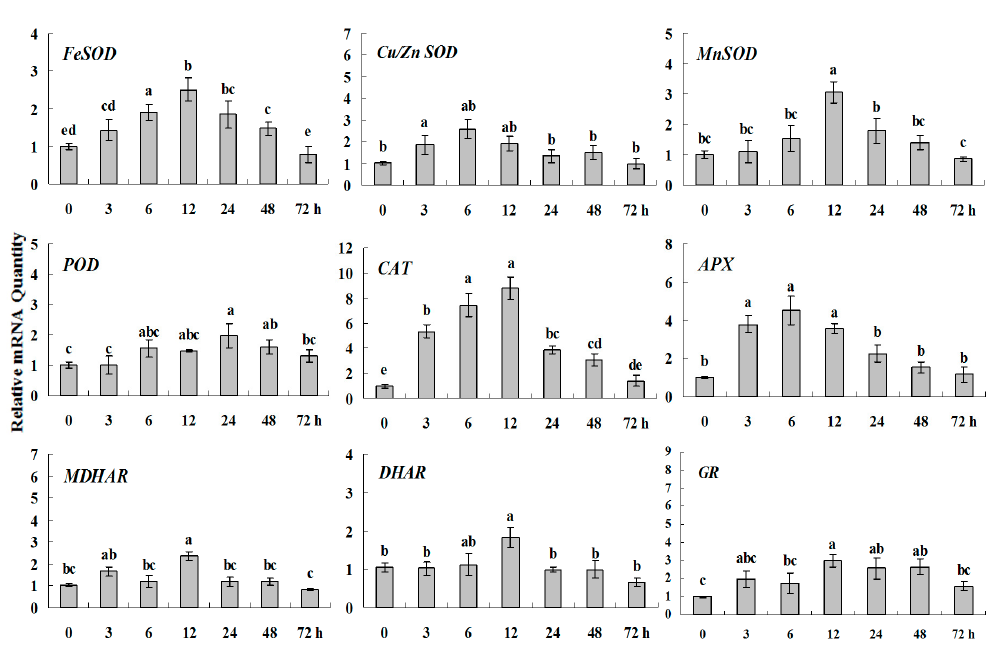
Figure 4 . Quantitative real-time RT-PCR was used to analyze of ROS-scavenging enzyme genes expression during drought stress and normalized to β - actin . White clover leaves were sampled after 0, 3, 6, 12, 24, 48 and 72 h treatment. Data represent means of three replicates. Error bars representing standard errors and the different letters above the bars represent significant difference ( p < 0.05).